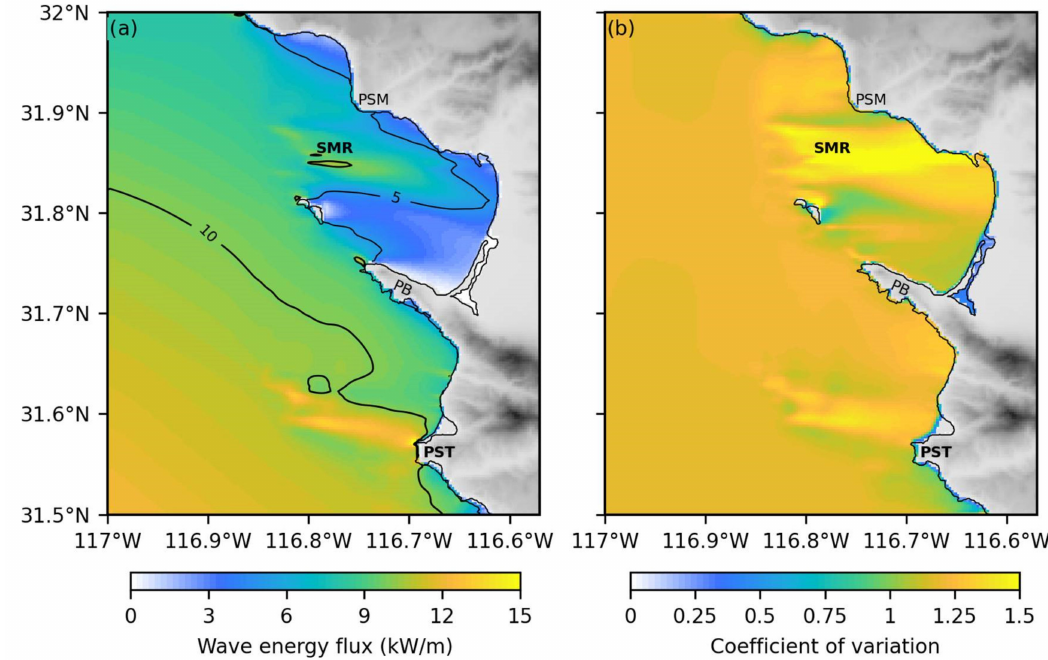
Figure 3. Mean available wave power ( a ) and CoV ( b ) over the full hindcast period. The selected sites, Punta Santo Tomas (PST) and San Miguel Reef (SMR), are in bold. The solid black lines in ( a ) represent wave power isolines, expressed in kW · m − 1